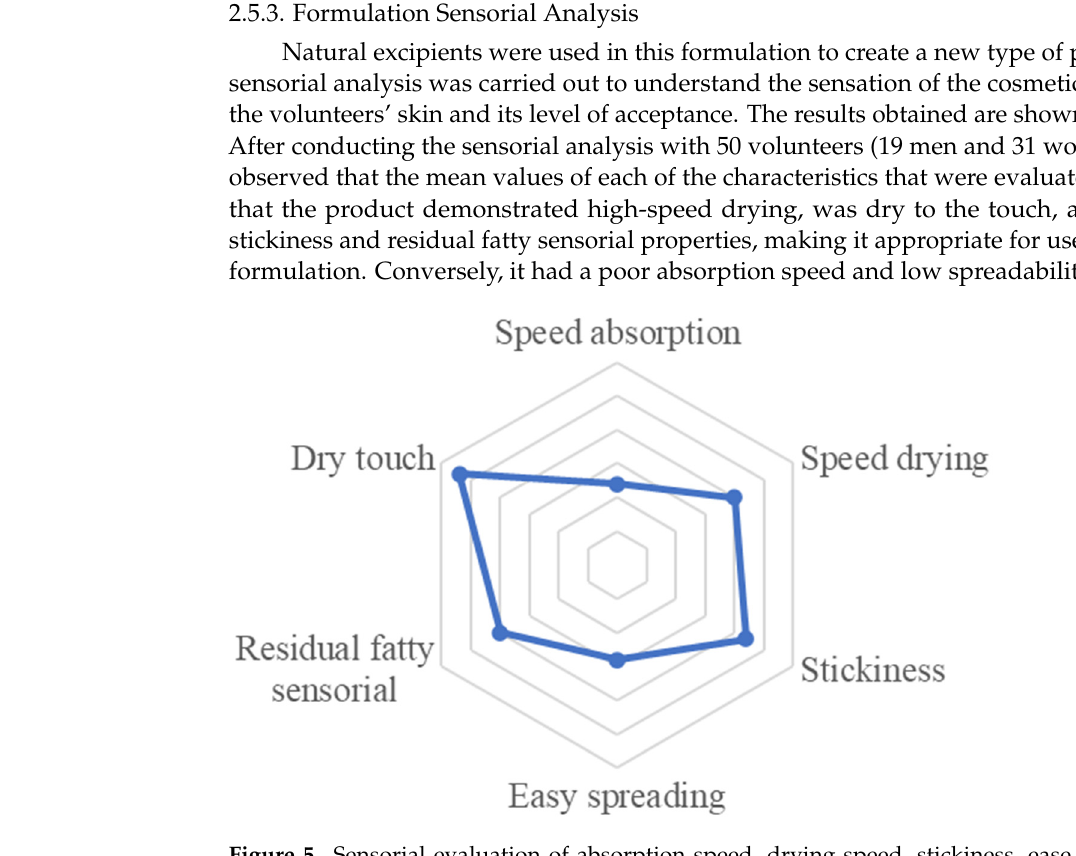
Figure 5. Sensorial evaluation of absorption speed, drying speed, stickiness, ease of spreading, re- sidual fatty sensorial properties, and dry touch of the O/W